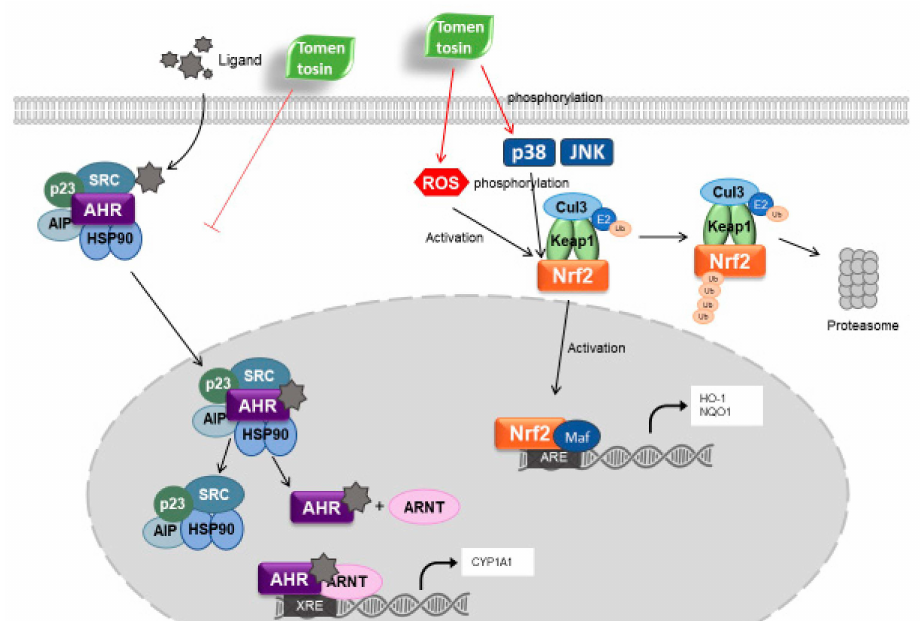
Figure 7. Action mechanism of tomentosin in the AHR/Nrf2-mediated signaling. Tomentosin activates Nrf2 signaling through activation of p38 MAPK and JNK as well as ROS production. Tomentosin also inhibits AHR signaling by suppressing nuclear translocation of AHR. Red line: Action step of